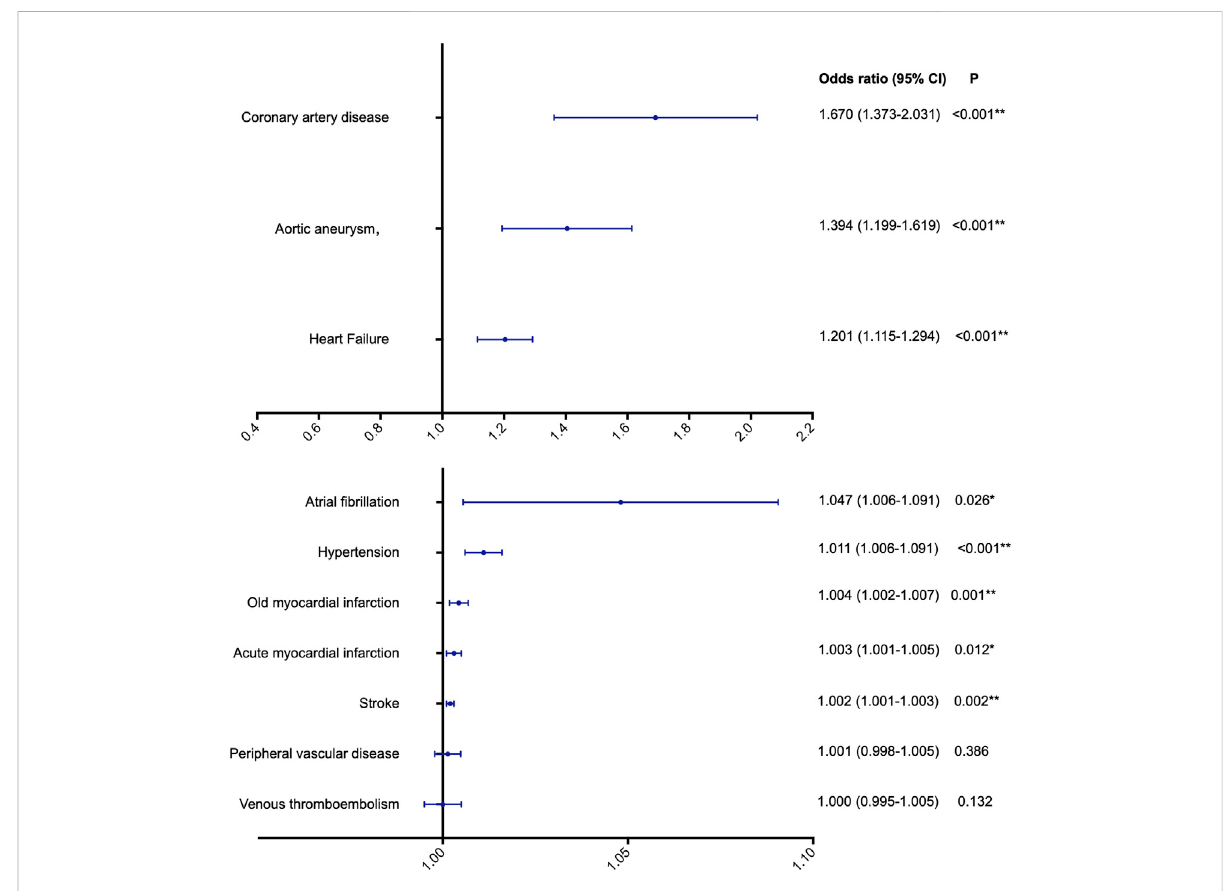
FIGURE 2 The potential causal association between lipoprotein metabolism and ten cardiovascular diseases. * p < 0.05, indicating a possible causal association; ** p < 0.005, indicating a signi fi cant causal